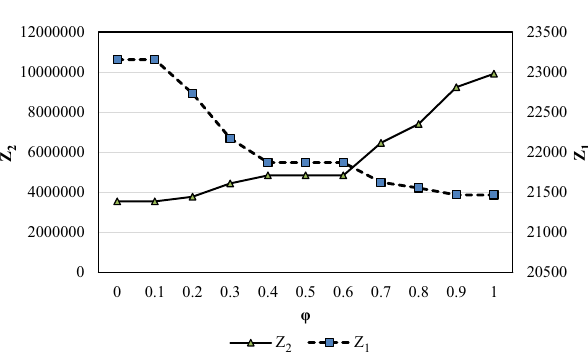
Table 12 The performance of the robust optimization model